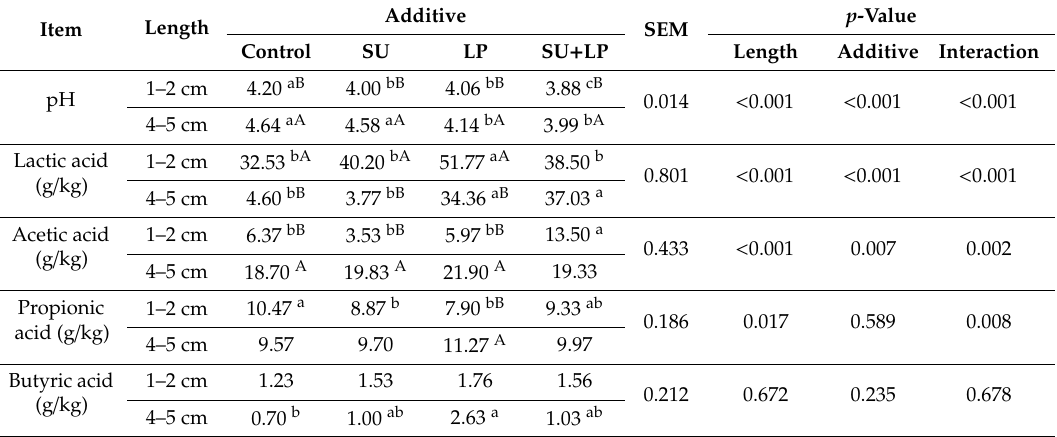
Table 2. The pH value and fermentation products of L. chinensis silage with di ff erent chopping lengths and additives after ensiling for 30 d (Dry matter